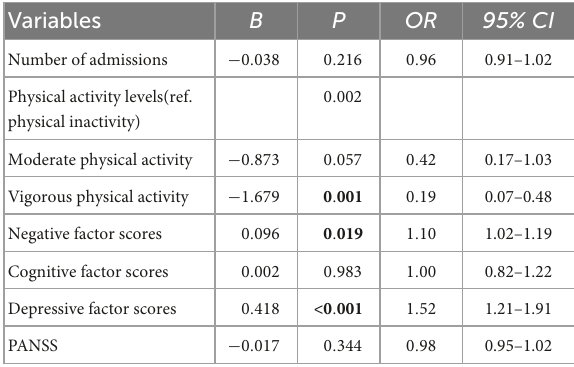
TABLE 4 Demographic and clinical variables independently associated with depressive symptoms by binary logistic regression